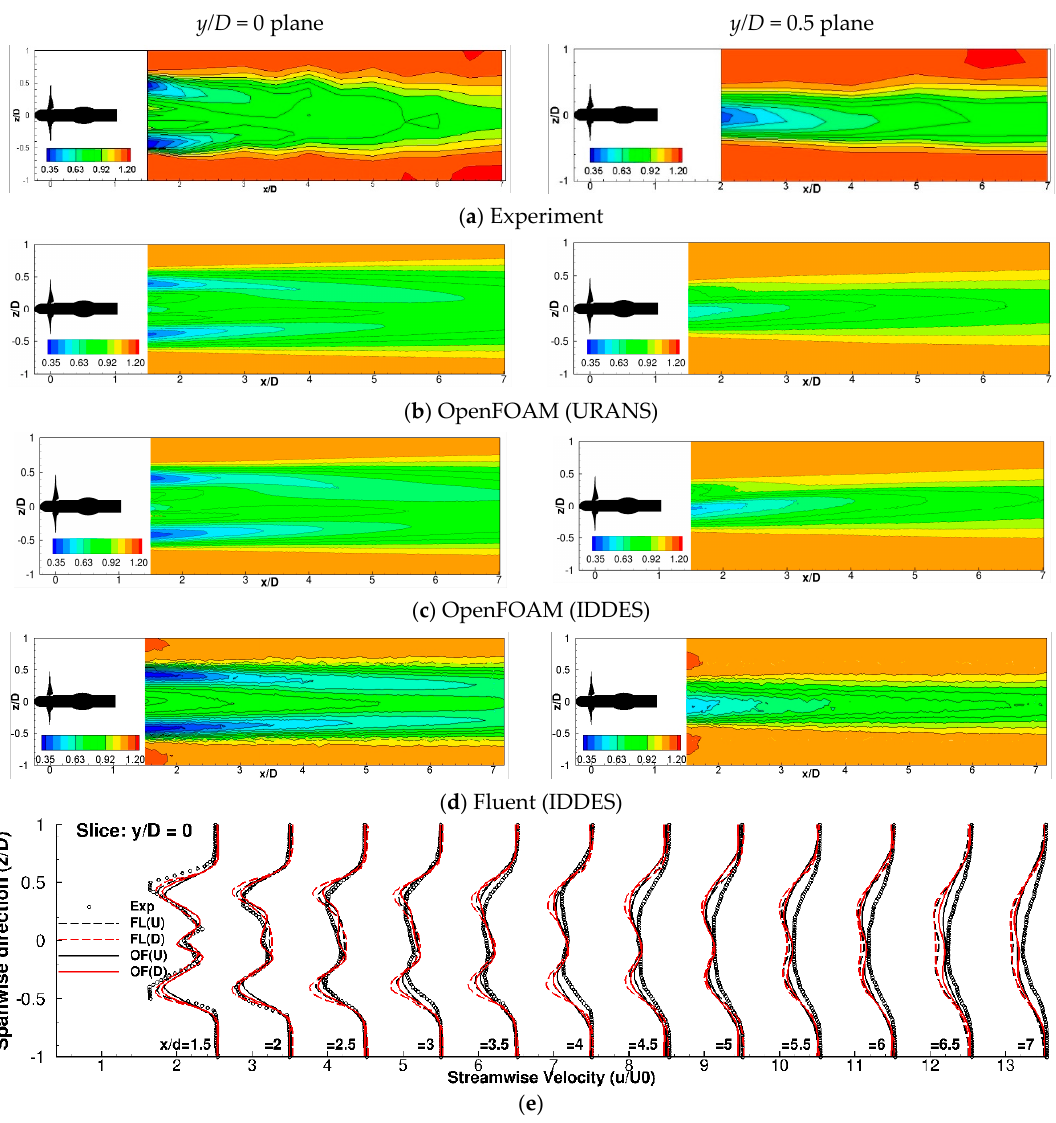
Figure 8. Mean streamwise velocity obtained from: ( a ) experiment [2], ( b ) OpenFOAM URANS, ( c ) OpenFOAM IDDES and ( d ) Ansys / Fluent IDDES. The left and right panels show the plots in y / D = 0 and 0.5 planes, respectively. ( e ) Wake deficit profiles 1 predicted in CFD simulations in y / D = 0 plane are compared with experimental data